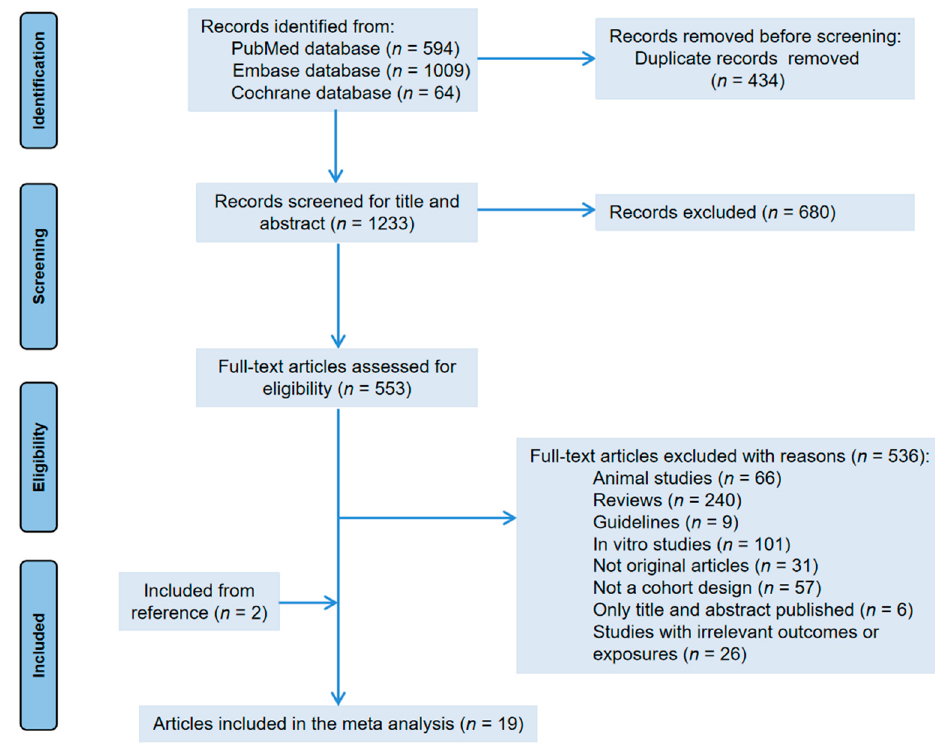
Figure 1. Flow chart of the study. Table 1. Characteristics of the included